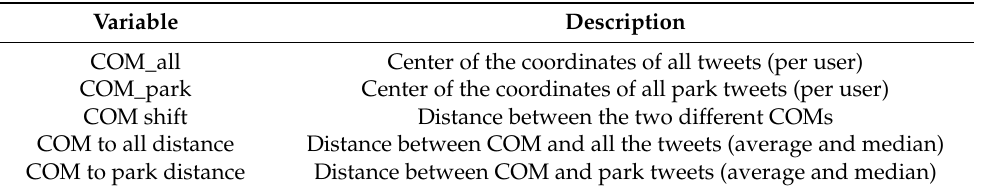
Table 3. Derived spatial variables for each user.